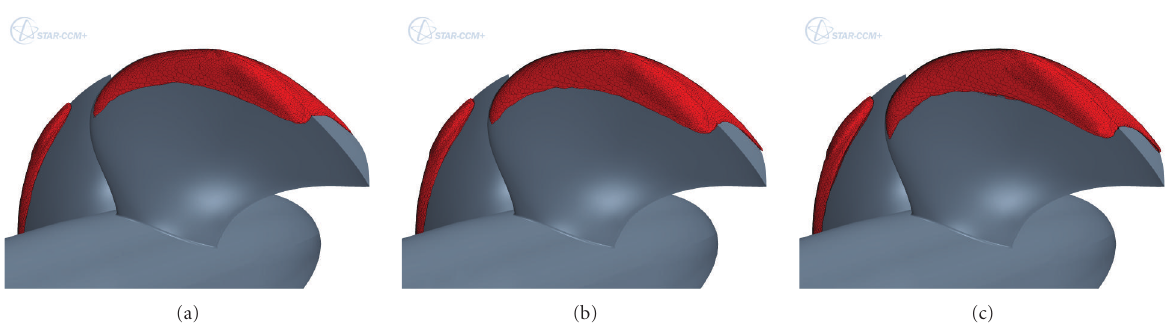
Figure 11: Convergence of cavity extension (fraction of vapor equal to 0.5) with the number of cells. Open water thrust coe ffi cient equal to 0.213 at cavitation index of 1.625.